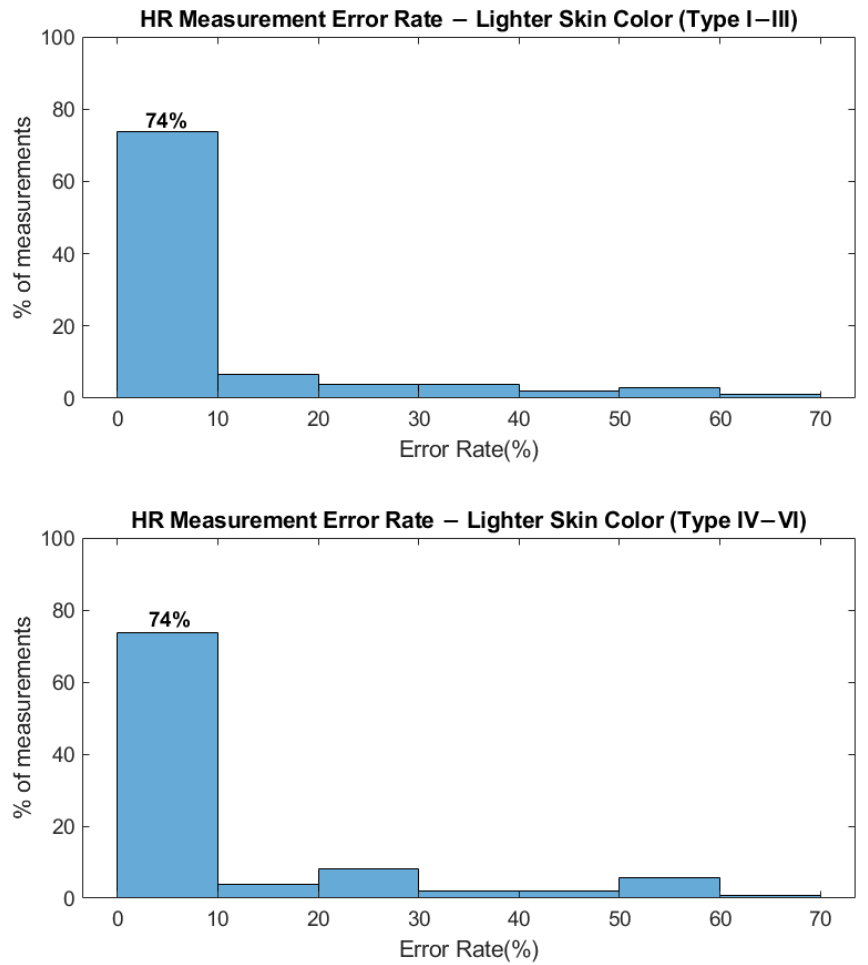
Figure 14. HR measurements error rate within groups of: lighter skin color ( top ) and darker skin color ( bottom